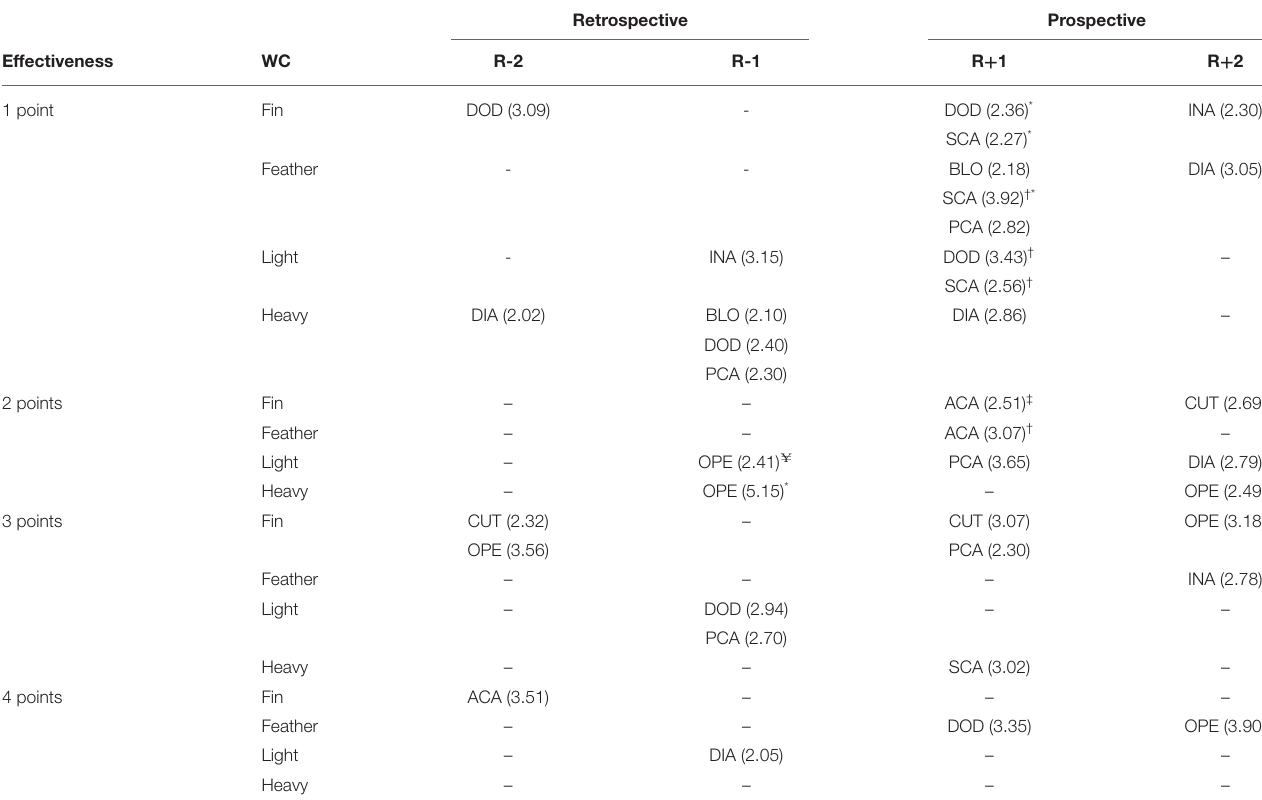
TABLE 2 | Positive relationships between tactical actions and effectiveness in retrospective and prospective perspective for